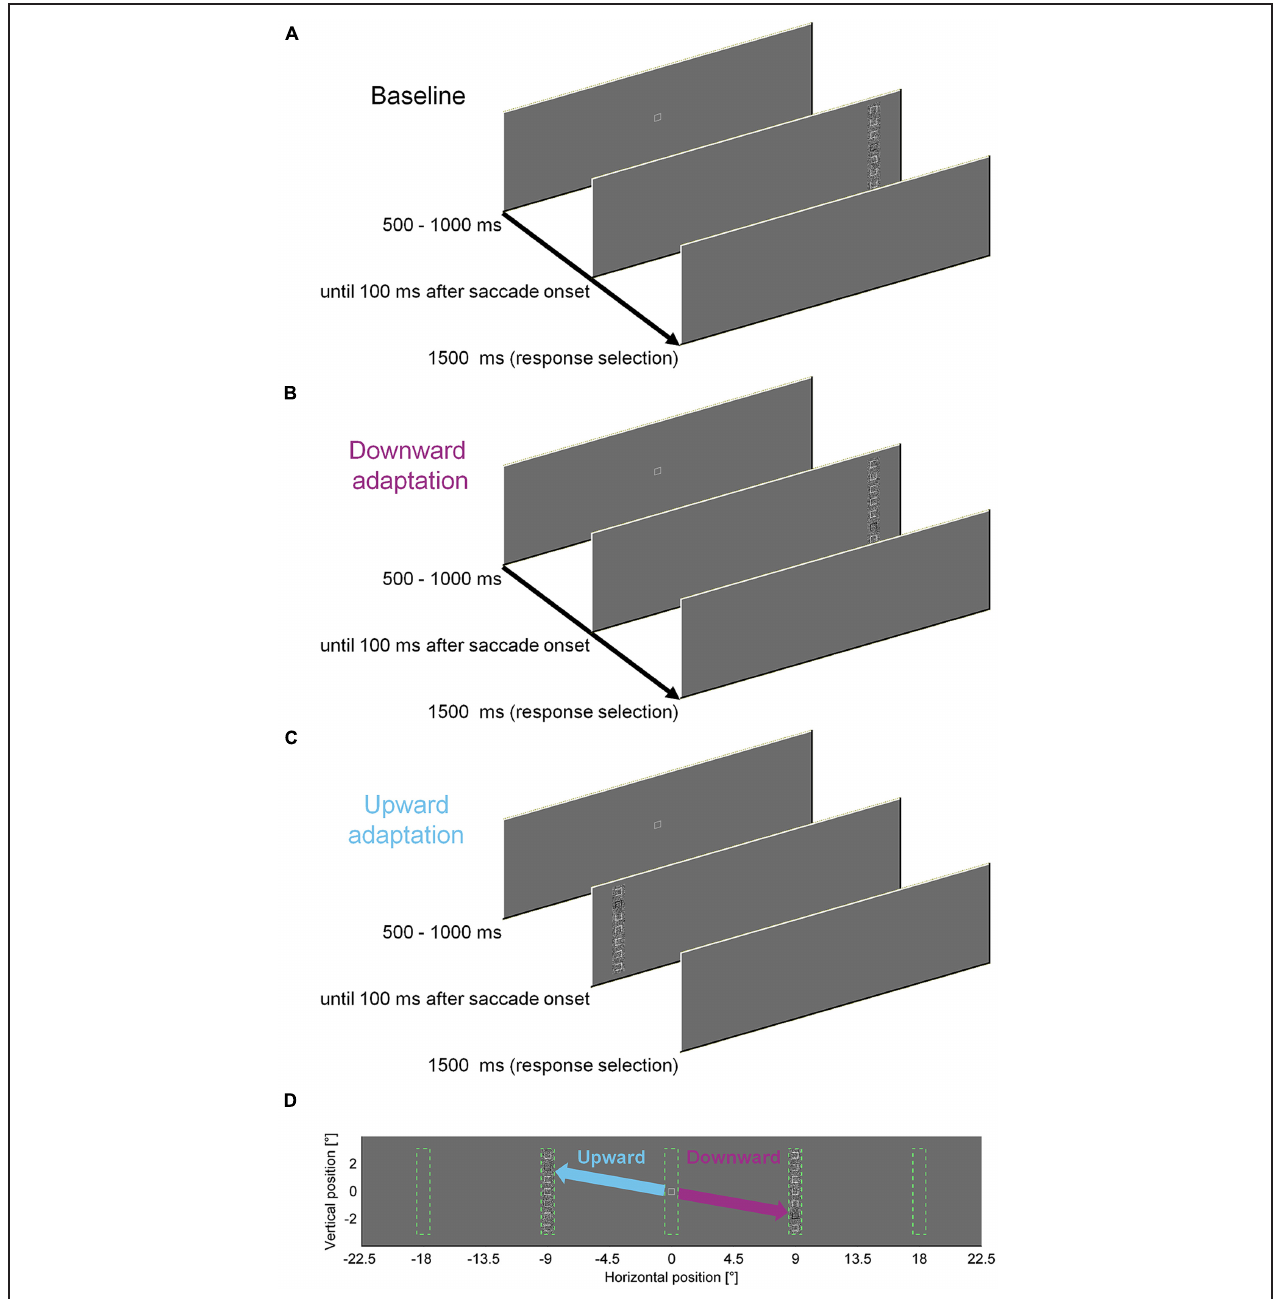
FIGURE 1 | Experimental paradigm to induce saccadic adaptation by a perceptual task. (A) Time course of one pre- or post-adaptation trial. In 100 pre- and 300 post-adaptation trials, the task-relevant square was located at the center of the compound. (B) Time course of one downward adaptation trial. In 300 adaptation trials, the task-relevant square was either located at the top or at the bottom of the compound, depending on the direction of the horizontal step. (C) Time course of one upward adaptation trial. (D) Potential locations of the compound and adaptation manipulation. Vertical compounds of squares could appear 9 ◦ to the left or to the right of initial fixation. Upward steps for leftward saccades and downward steps for leftward saccades were counterbalanced across observers. Compared to a previous study (Schütz et al., 2014), the individual elements were squares rather than characters. Moreover the task-relevant element was marked in black throughout the stimulus presentation, as in Experiment 8 in Schütz et al. (2014).